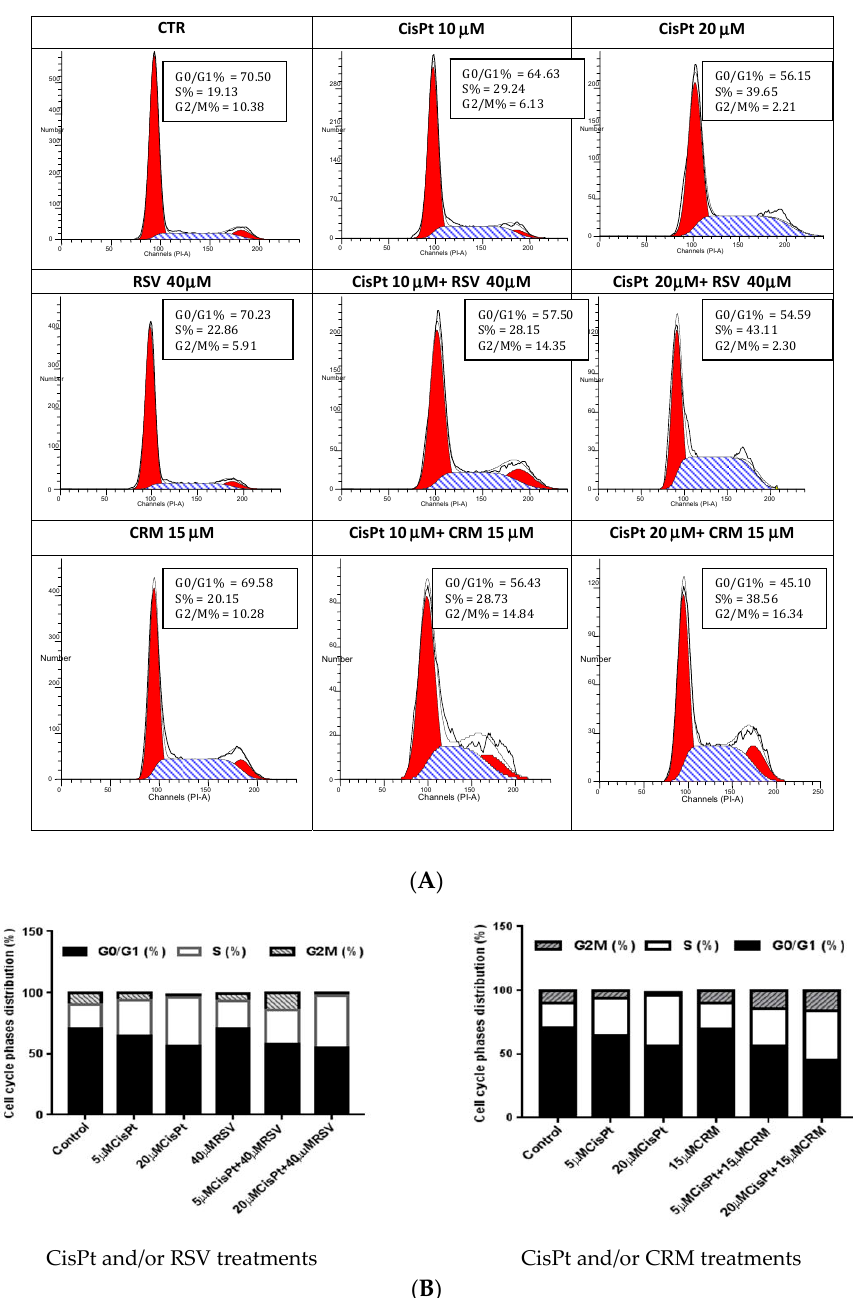
Figure 6. The effect of treatments with CisPt, RSV, CRM applied independently or in combination on normal cells HUVEC on the cell cycle phases distribution. ( A ) flow cytometry histograms; ( B ) cell cycle phases distribution (%).